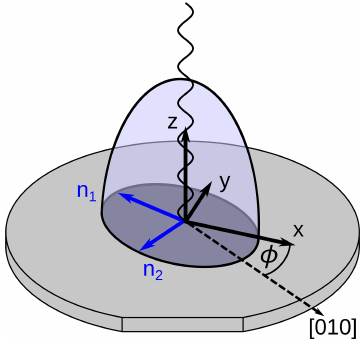
Figure 3. Orientation of the indicatrix on a {100}-silicon wafer to describe the birefringence with reference to the global ( x , y , z ) co- ordinate system where the x – y plane is located on the [001]